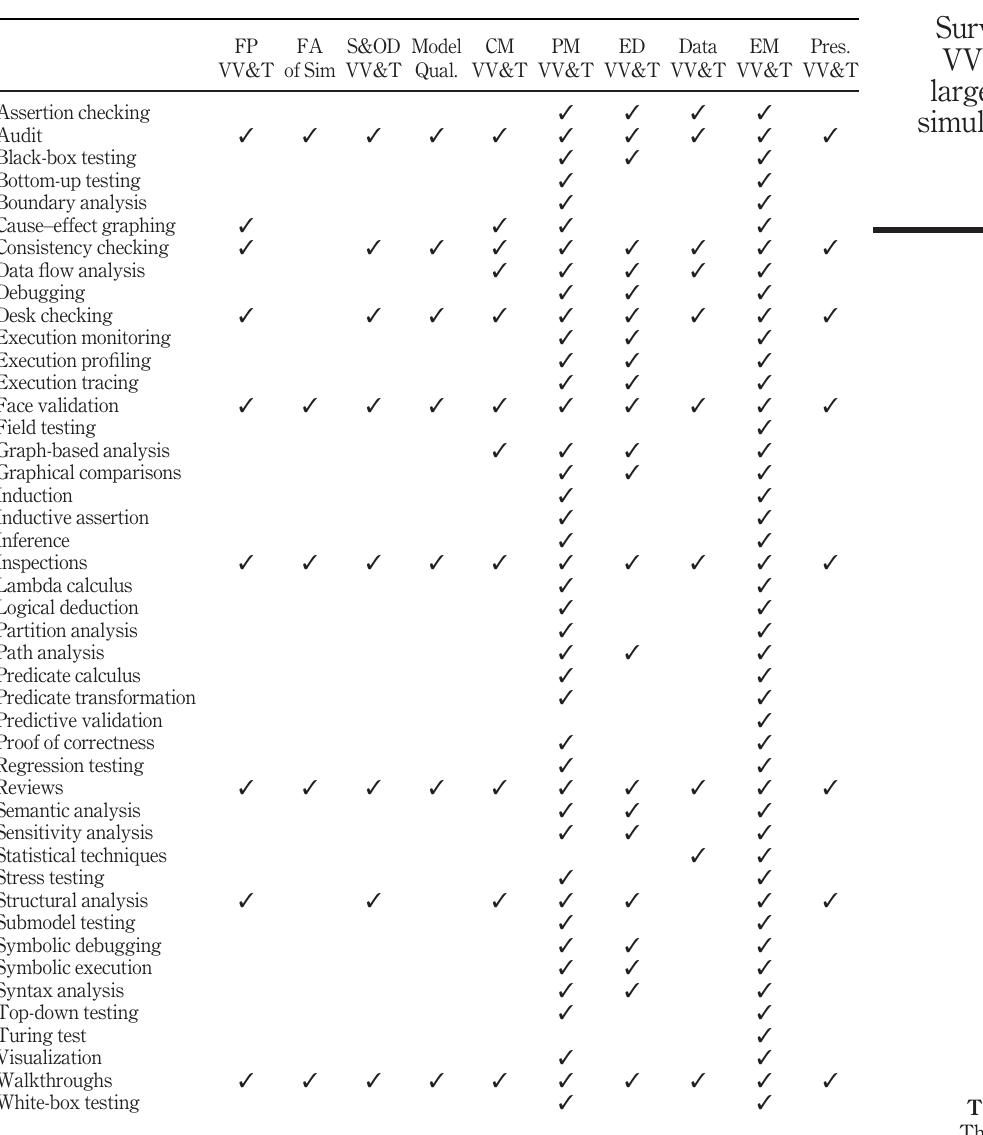
Table IV. The VV&T techniques for the credibility assessment stages